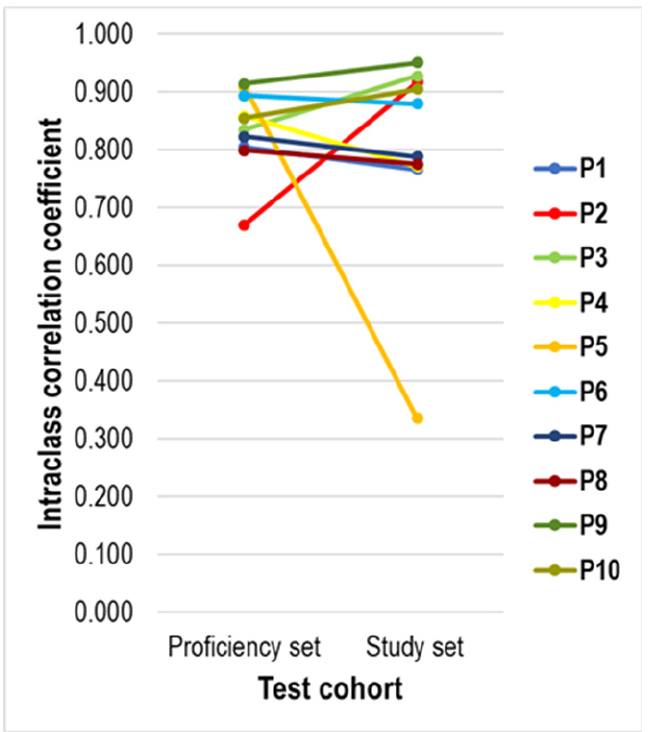
Figure 6. Line diagram showing the evolution between the agreement of the PD-L1 score of each pathologist with the median Px PD-L1 score in the proficiency set and the study set. The PD-L1 assessment of most pathologists showed a similar degree of agreement, except for P2 (higher agreement in the study set) and P5 (higher agreement in the proficiency